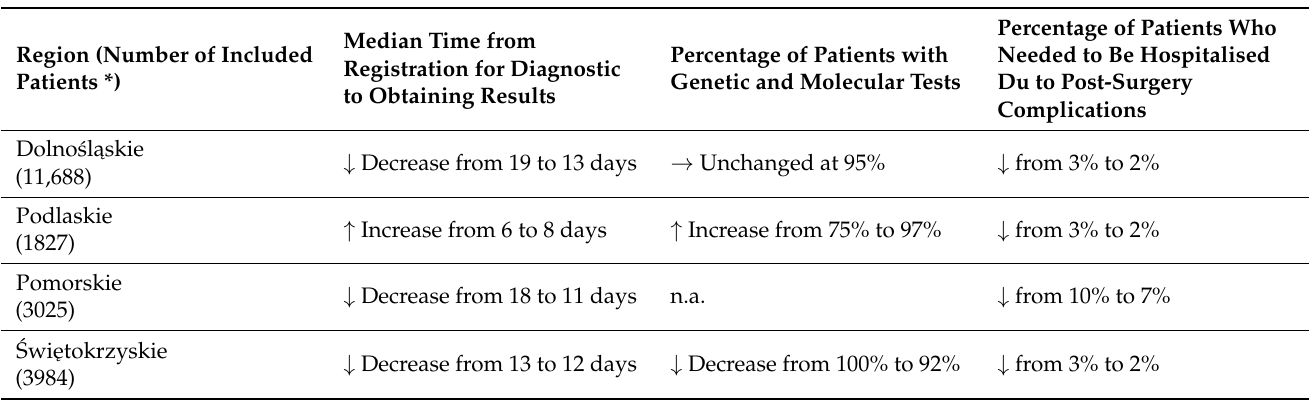
Table A2. Selected results of the National Oncology Network pilots in the four regions,